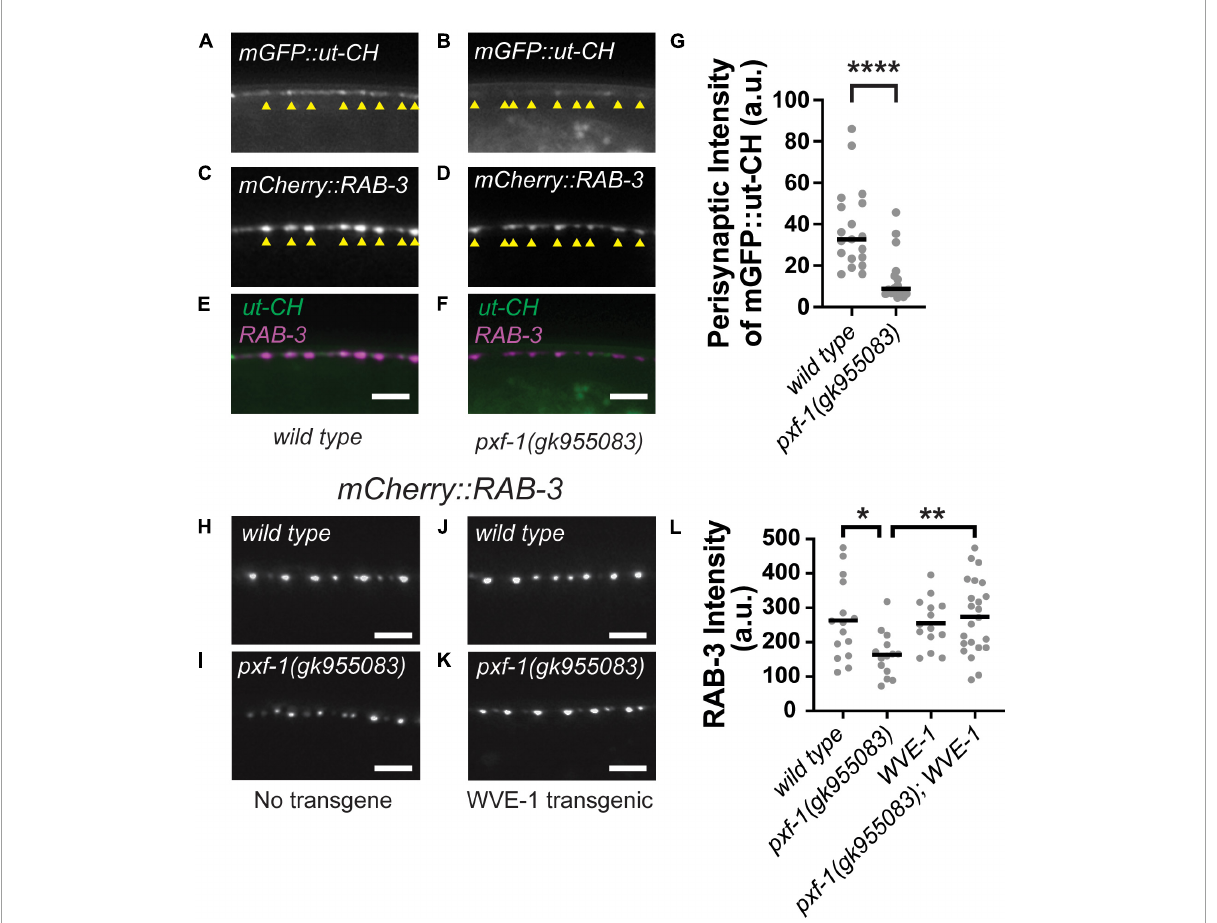
FIGURE6 Perisynaptic mGFP:ut-CH is reduced in pxf-1 mutant animals. (A–F) Representative images of (A,B) mGFP labeled calponin homology domain of F-actin binding protein utrophin, (C,D) mCherry:RAB-3 labeled acetylcholine synapses, and (E,F) merged channels in dorsal cord of wild type and pxf-1(gk955083) mutants. Yellow arrowheads indicate position of mCherry:RAB-3 labeled presynaptic terminals. Scale bars are 5 µ m. (G) Comparison of intensities of mGFP:ut-CH puncta within 1 µ m of mCherry:RAB-3 puncta measured in arbitrary units, a.u. Gray dots represent individual animals, black bars indicate medians. n = 16–19 animals. **** p < 0.0001. (H–K) Representative images of mCherry:RAB-3 labeled acetylcholine synapses in wild type and pxf-1(gk955083) animals in the presence or absence of Prgef-1:wve-1 cDNA transgene. Scale bars are 5 µ m. (L) Quantification of mCherry:RAB-3 from the indicated genotypes. Gray dots represent individual animals, black bars indicate means. n = 14–23. * p < 0.05; ** p <